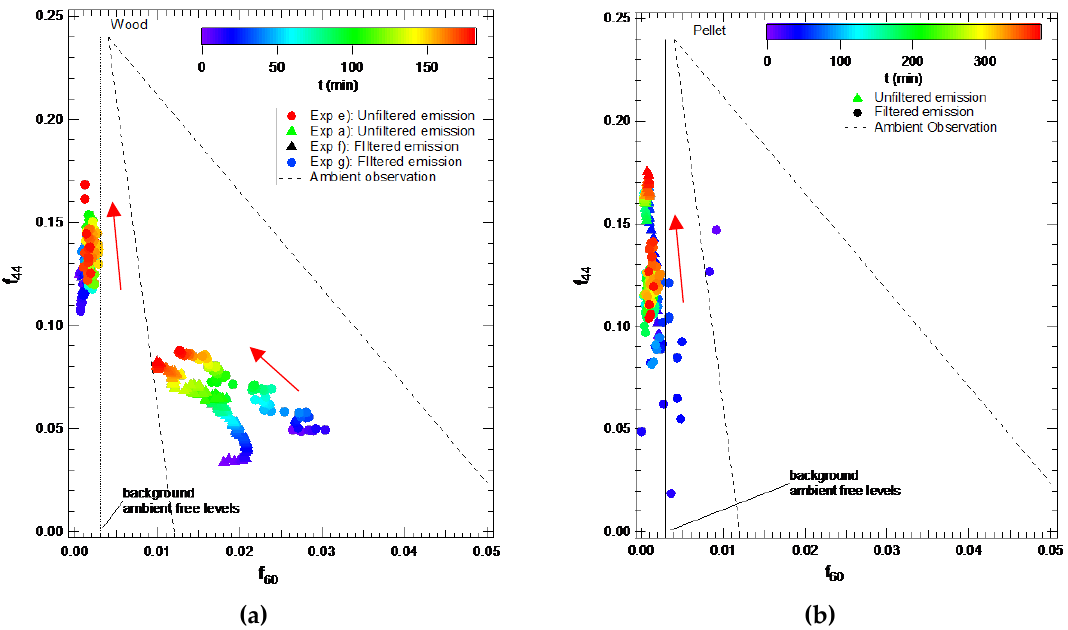
Figure 9. ( a ) f 44 (dominated by the CO 2 + ion) vs. f 60 (dominated by levoglucosan) for all wood experiments ( b ) for pellet experiments. The evolution of the factors with time is shown with the red arrow [25,50].